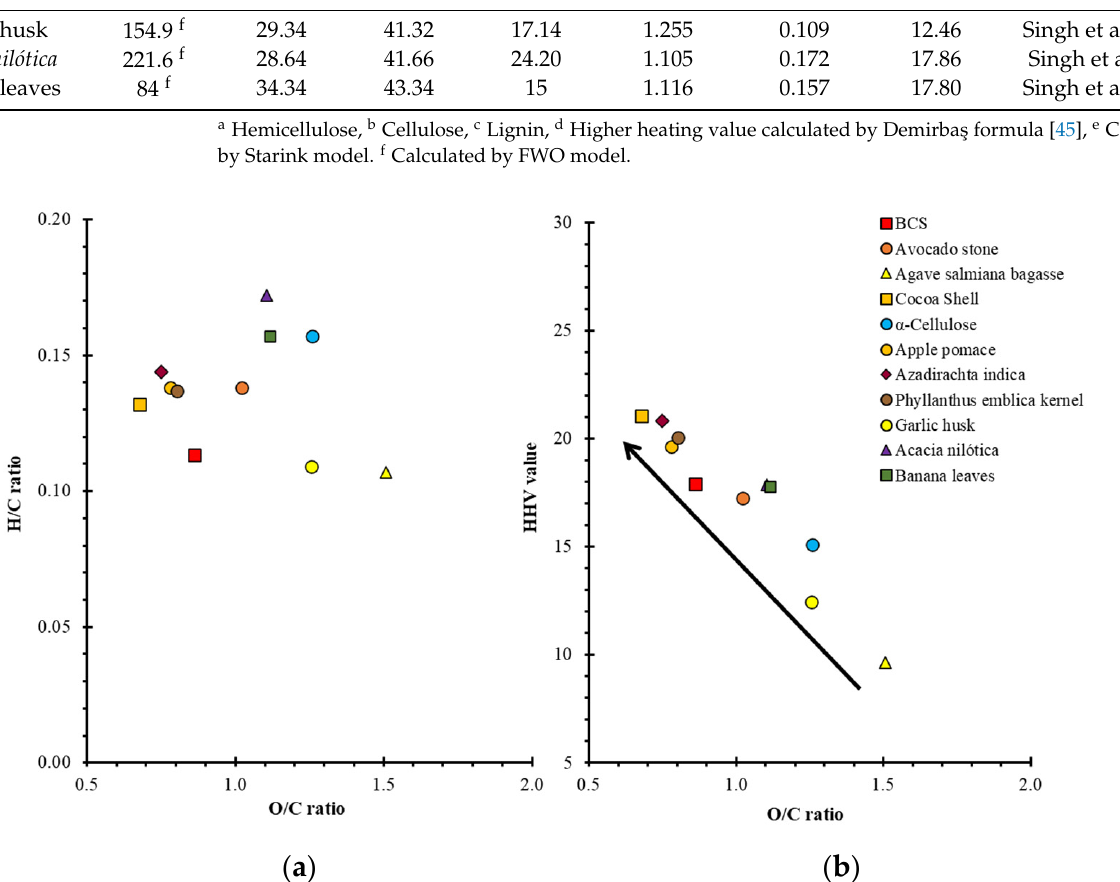
Table 3. Comparison of apparent activation energy, structural composition, elemental ratios, and HHV values by different biomass.